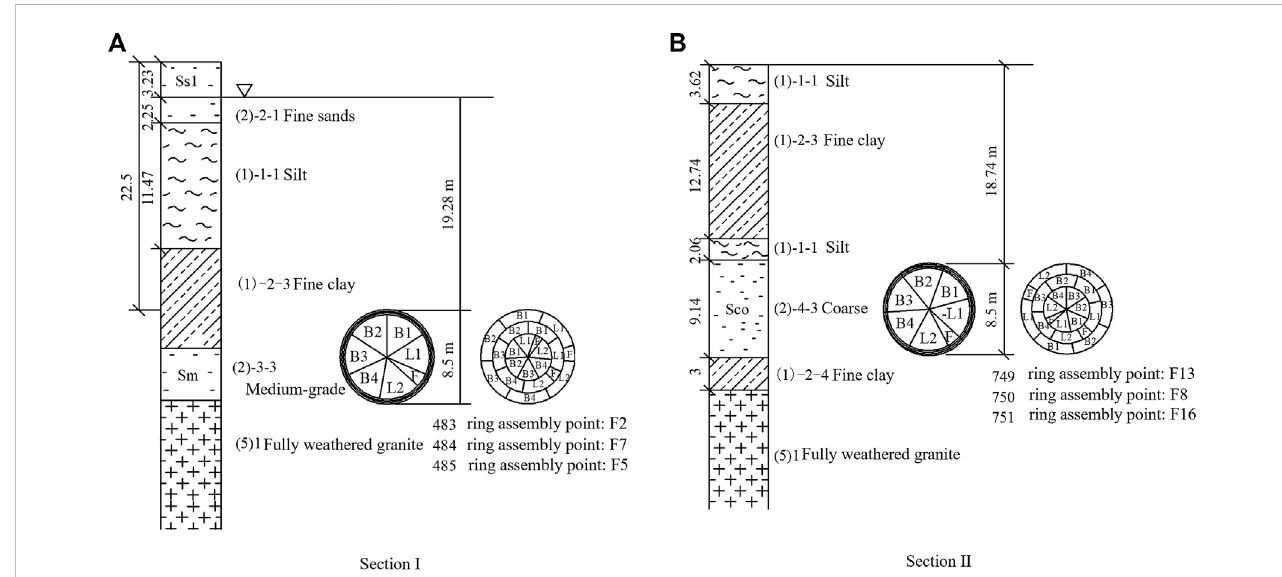
FIGURE 10 Stratum distribution of each monitoring section (unit: m). (A) Section I, (B) Section II.